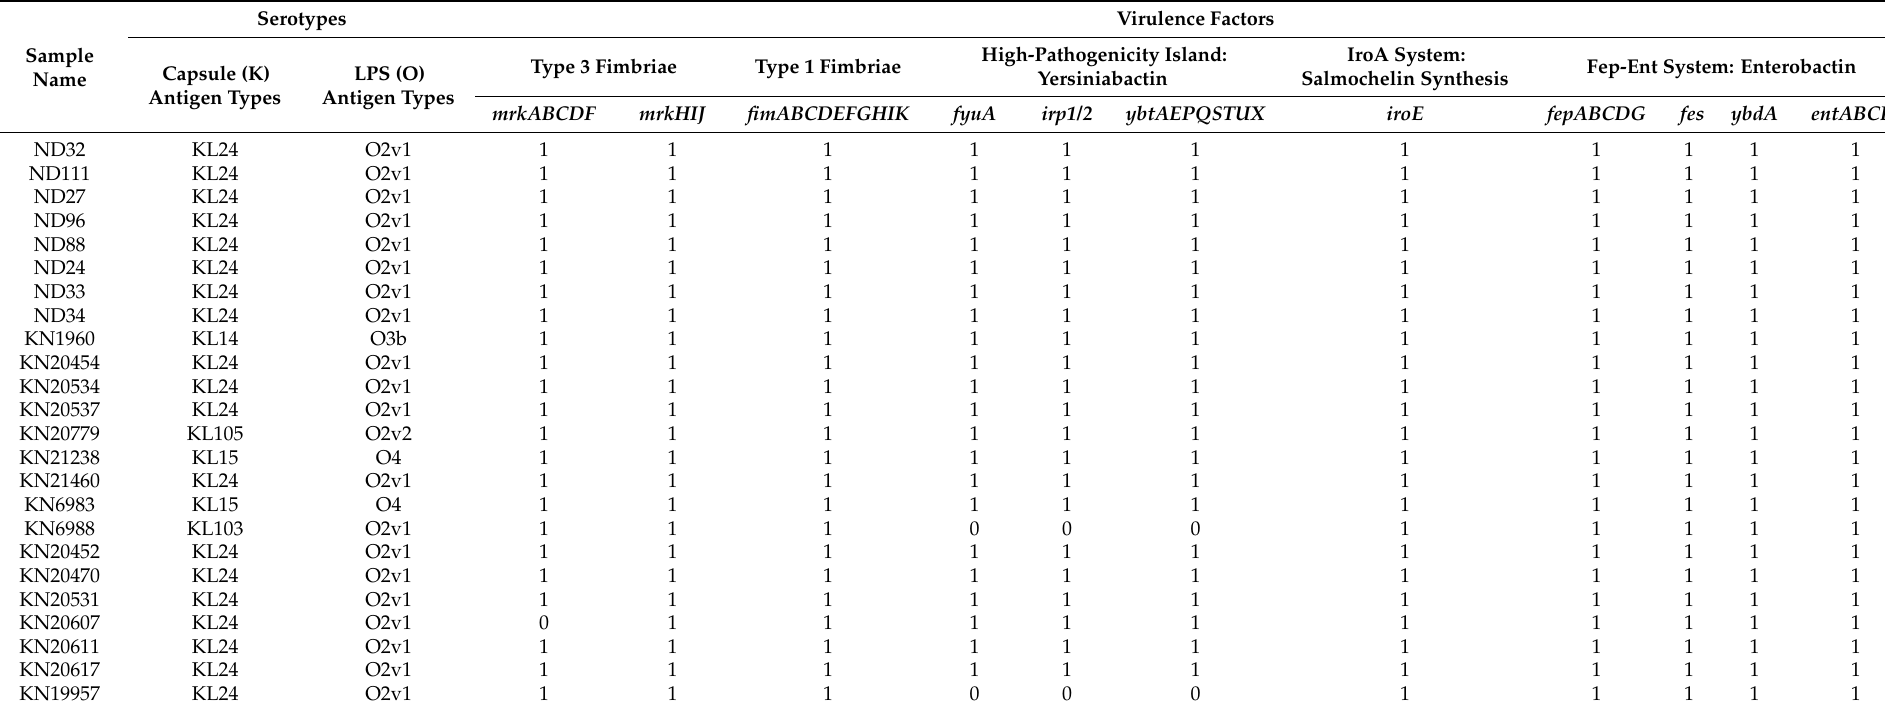
Table 4. K. pneumoniae NDM-1 ST11 isolates sequenced in this study and those included from the PATRIC database, serotype data, and virulomes. Legend: 0—absence,